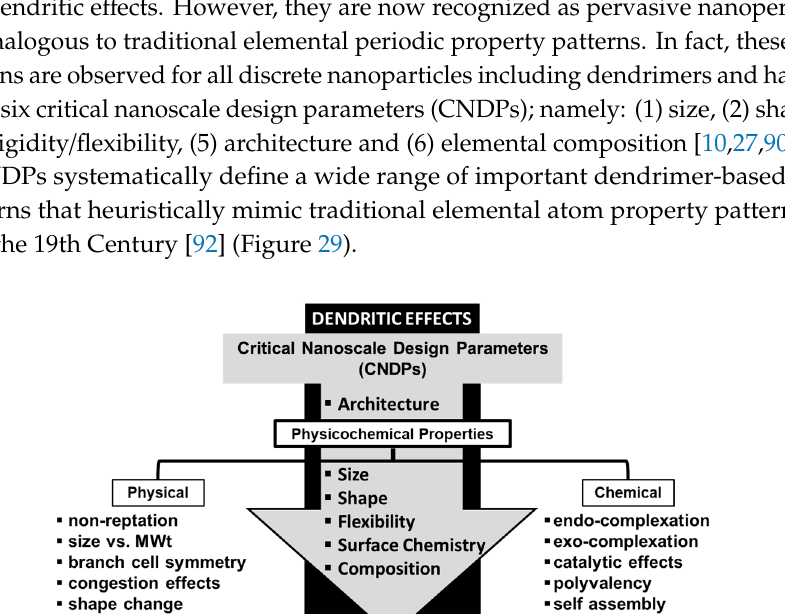
Figure 30. Engineering critical nanoscale design parameters using dendritic architecture, ( I ) size, ( II ) shape, ( III ) surface chemistry, ( IV ) flexibility/rigidity, ( V ) architecture and elemental composition. More specifically, an approach developed by Huang and Tomalia [96] referred to as the differentiated dendroid template (DDT) strategy demonstrates the degree of control that is possible over the synthetic construction of certain dendrimer structures; wherein, essentially all six CNDPs may be systematically engineered and tuned. This approach first involves the synthesis of partial